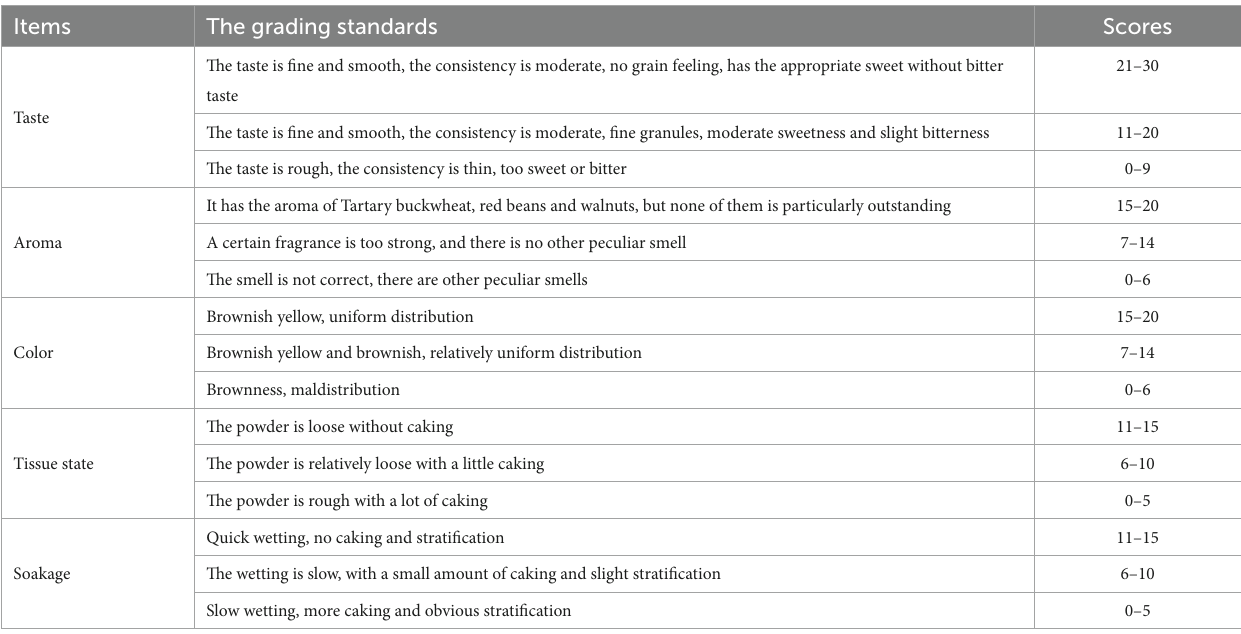
TABLE 1 The sensory evaluation criteria of different instant powder